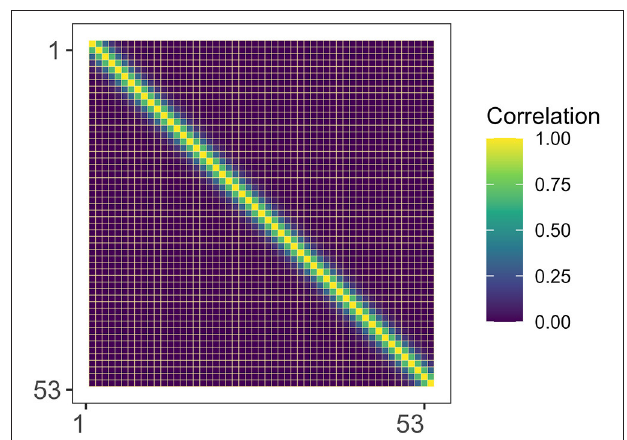
FIGURE 2 | Graphical representation of the assumed correlation matrix (cid:127) .